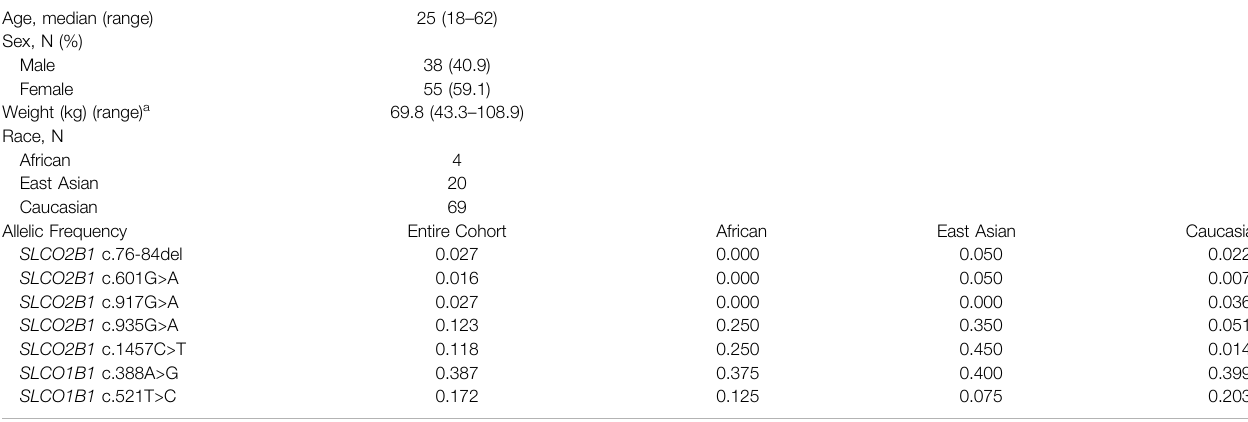
TABLE 3 | Study participant demographics ( n (cid:2) 93). Age, median